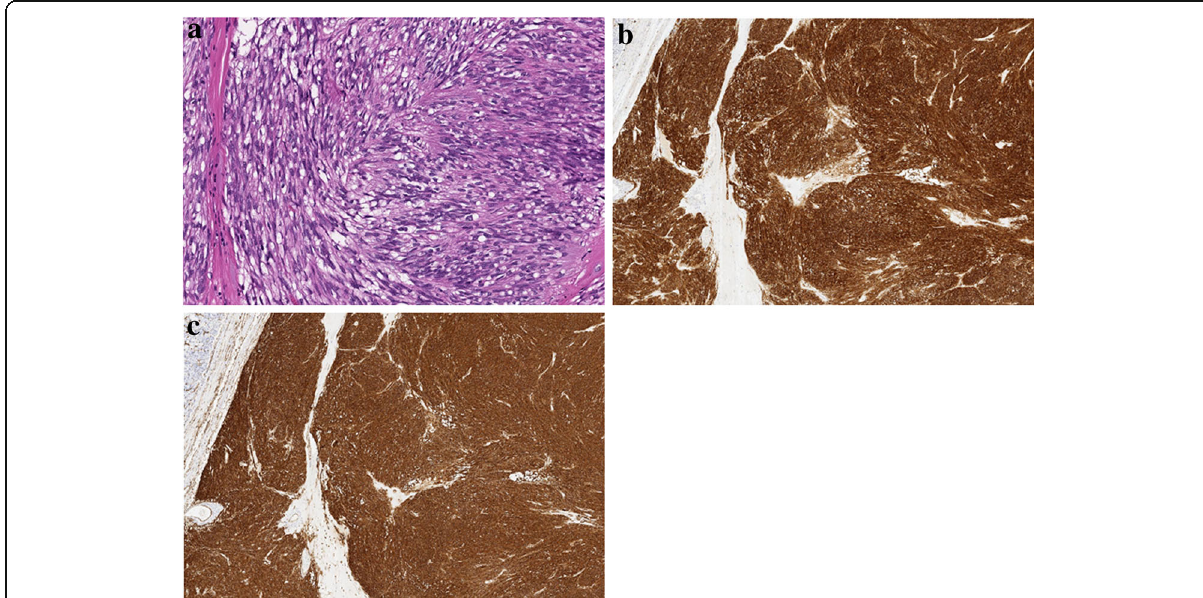
Fig. 6 Histological findings of the resected specimen. a Hematoxylin and eosin staining (high-power field). b Positive immunostaining result for c-kit. c Positive immunostaining result for